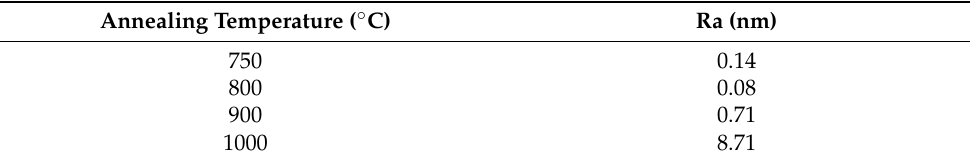
Table 1. Roughness of films (Ra) for several annealing temperatures .